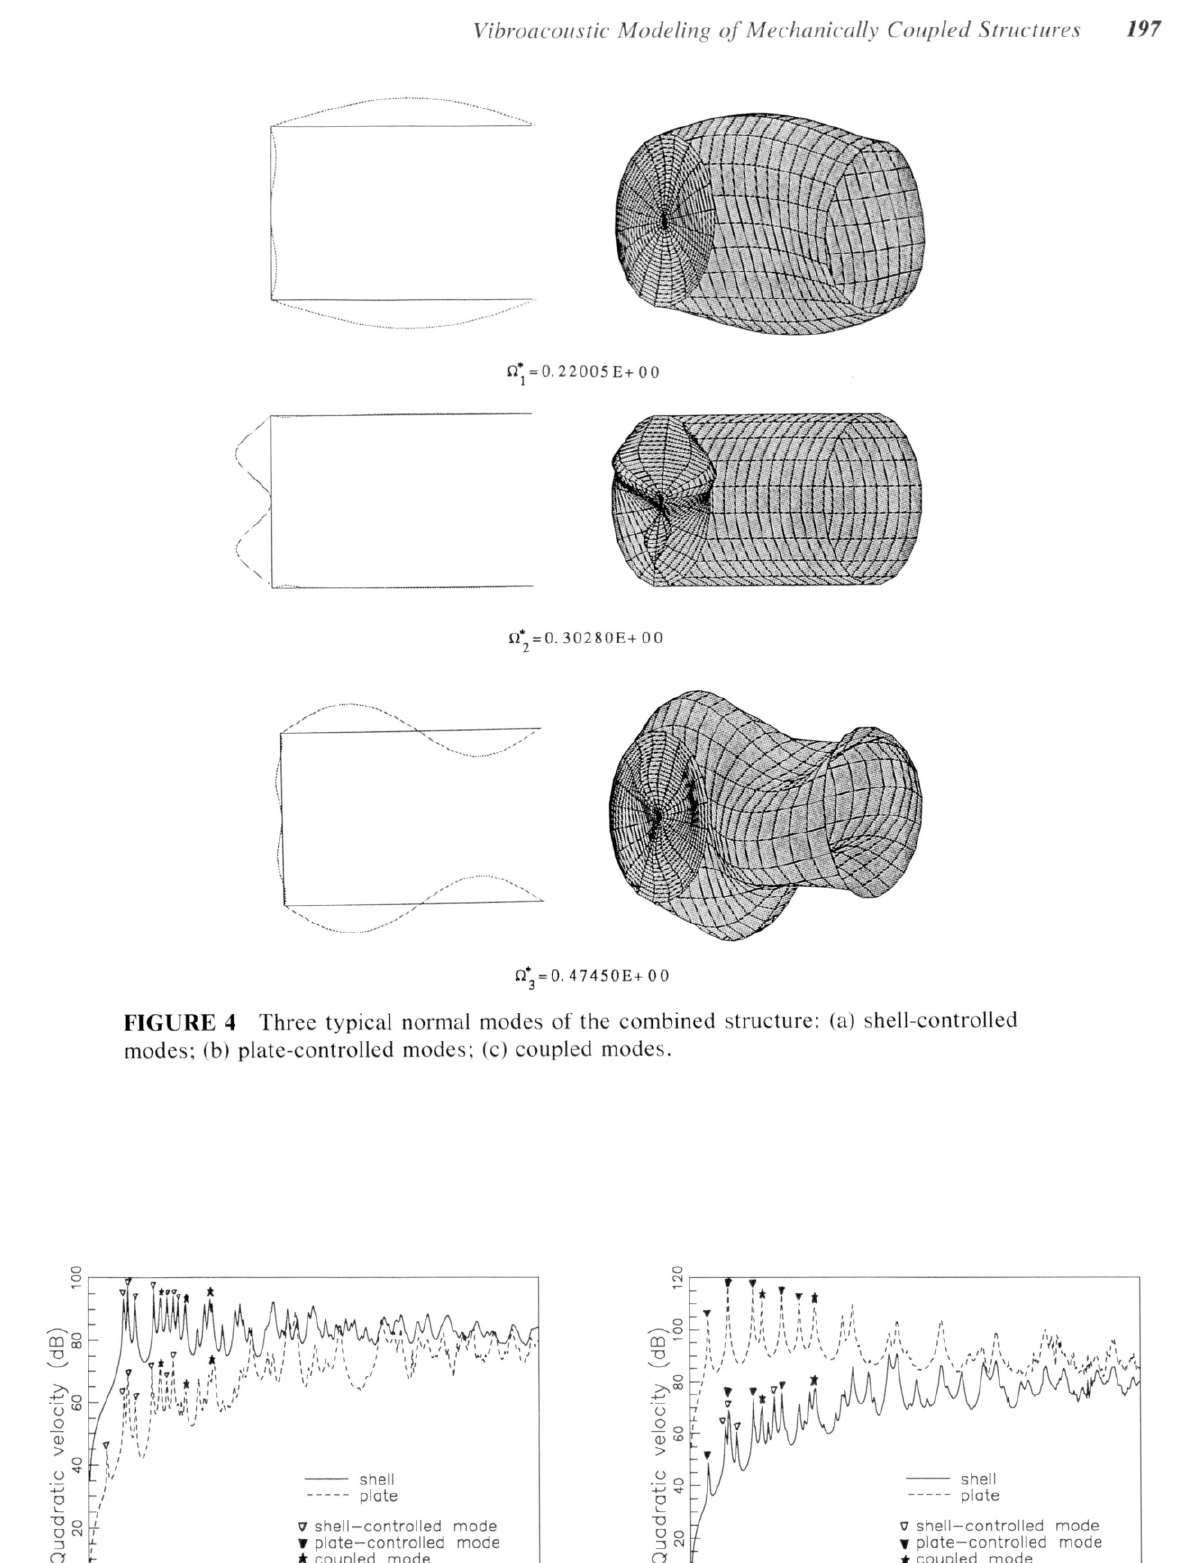
FIGURE 6 Quadratic velocity of the structure with the end plate subjected to a unit point